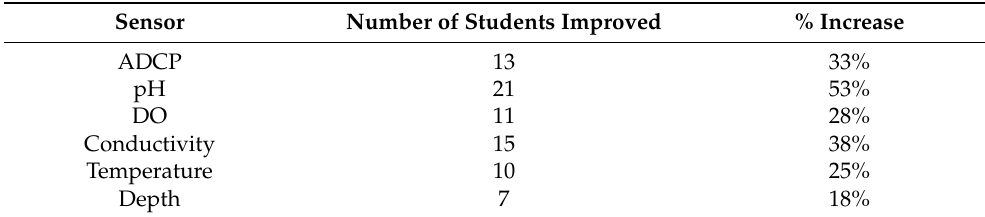
Table 7. Number of open response student scores that improved before and after intervention by sensor